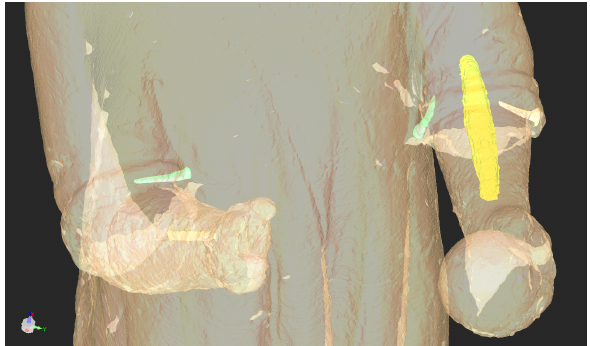
Figure 11: 3D object reconstruction of the infant. Nails and rivets beside the wooden joint (in one hand) are